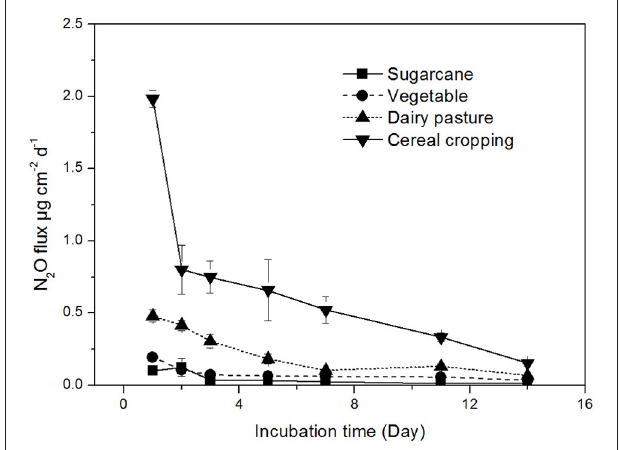
FIGURE 1 | Soil N 2 O production rates from different agricultural soils. Error bars represent standard